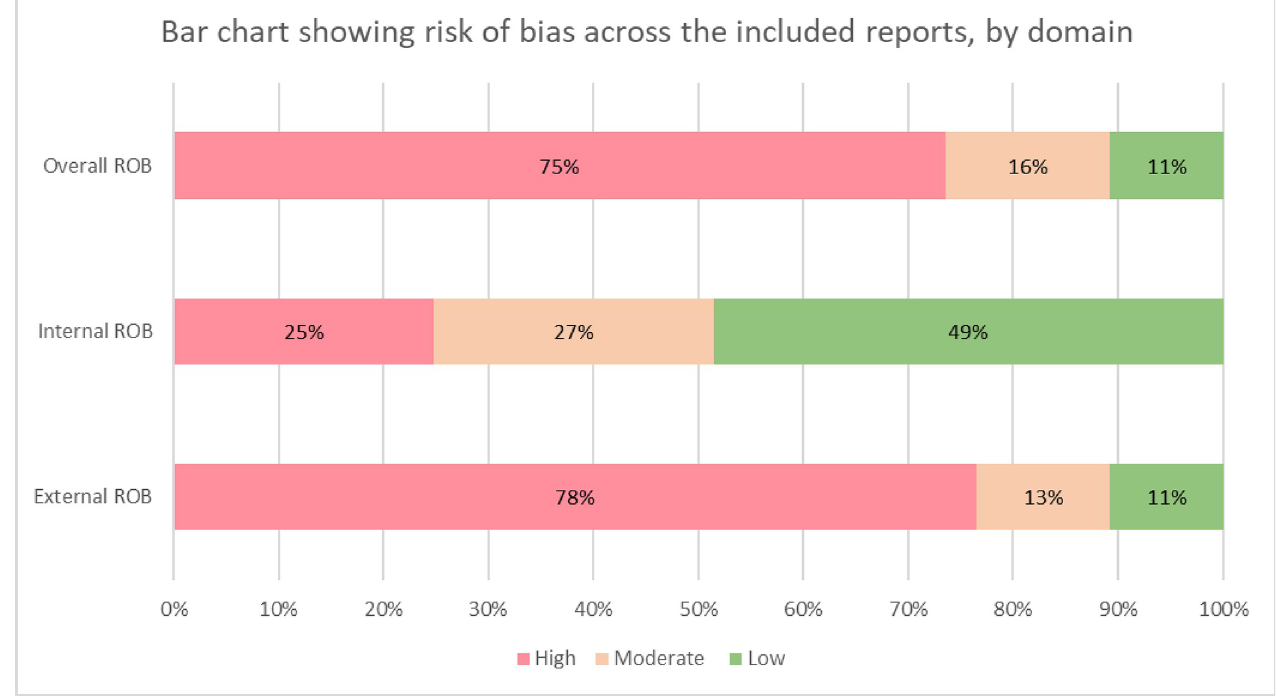
Fig 4. Showing the risk of bias across the included reports, by